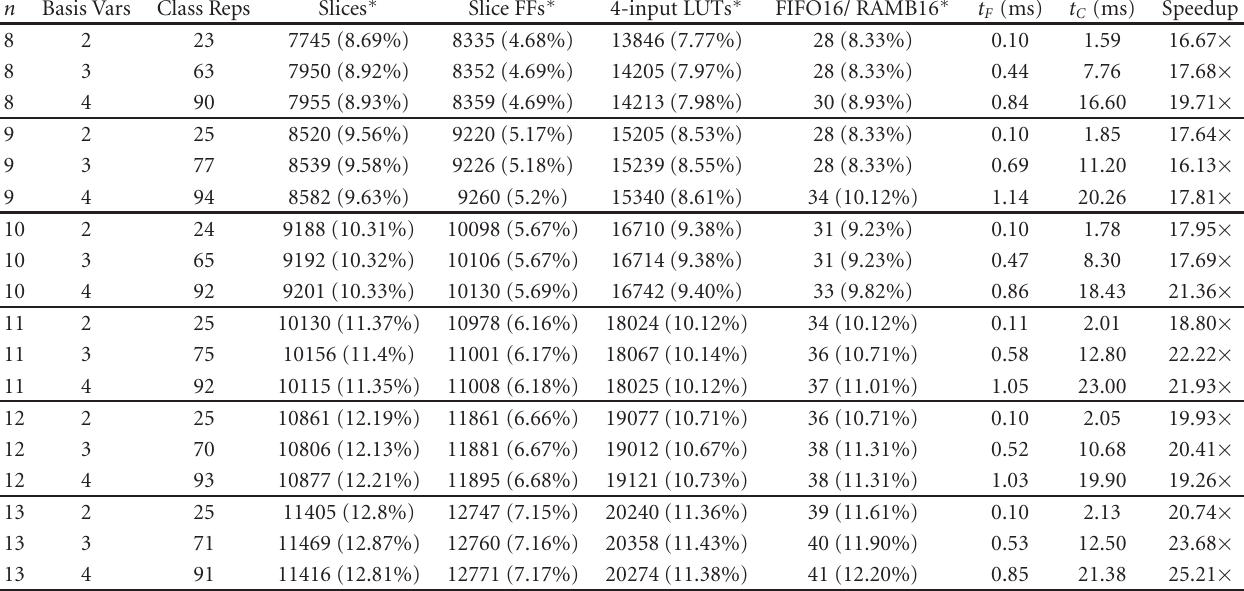
Table 6: Experimental results for stage